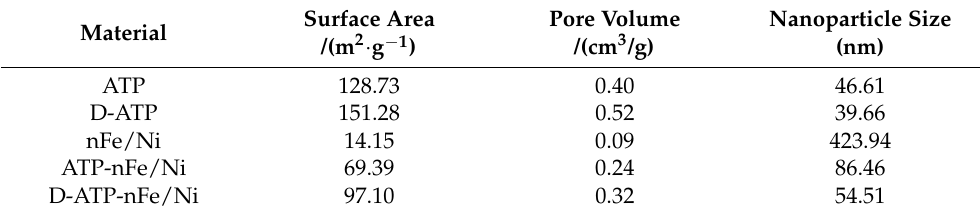
Table 1. Specific surface area, pore parameters and average size of materials.